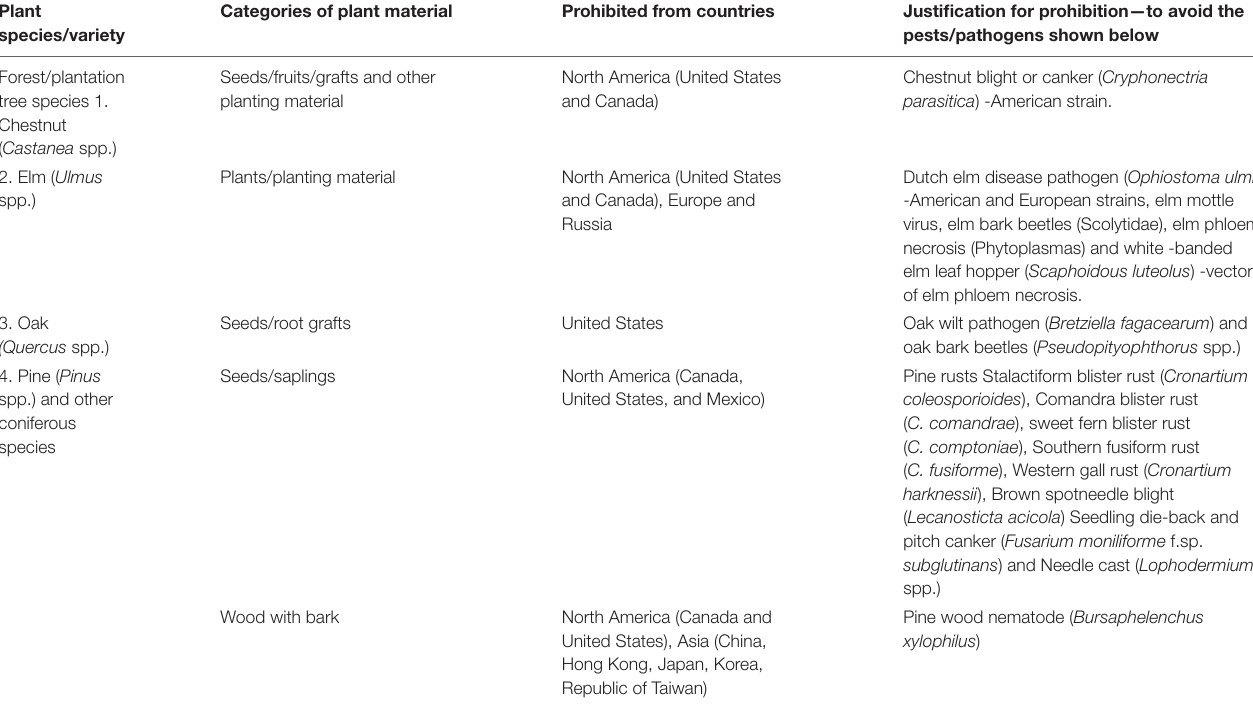
pests/pathogens shown below